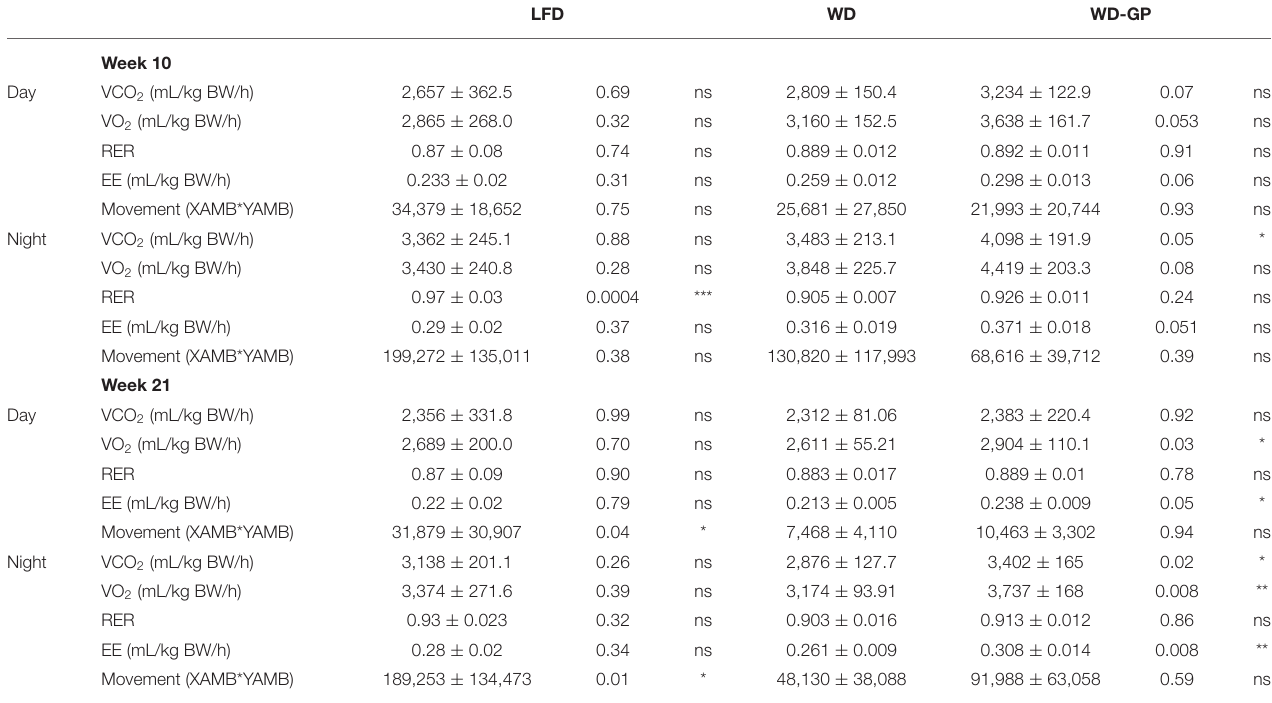
TABLE 1 | Metabolic activity measured by indirect calorimetry.